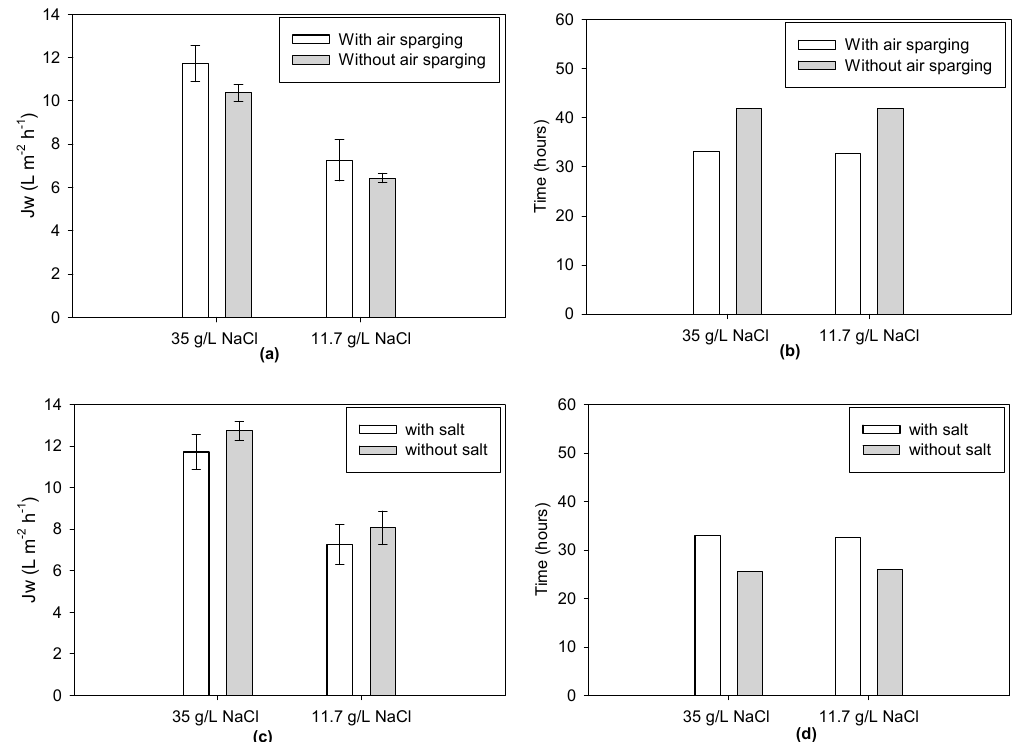
Figure 4. Average water fluxes during the first 2 h of each test ( a , c ); total filtration time for 35 g / L of draw solute (without re-concentration) and for the 11.7 g / L constant draw solute concentration under di ff erent conditions ( b , d ).